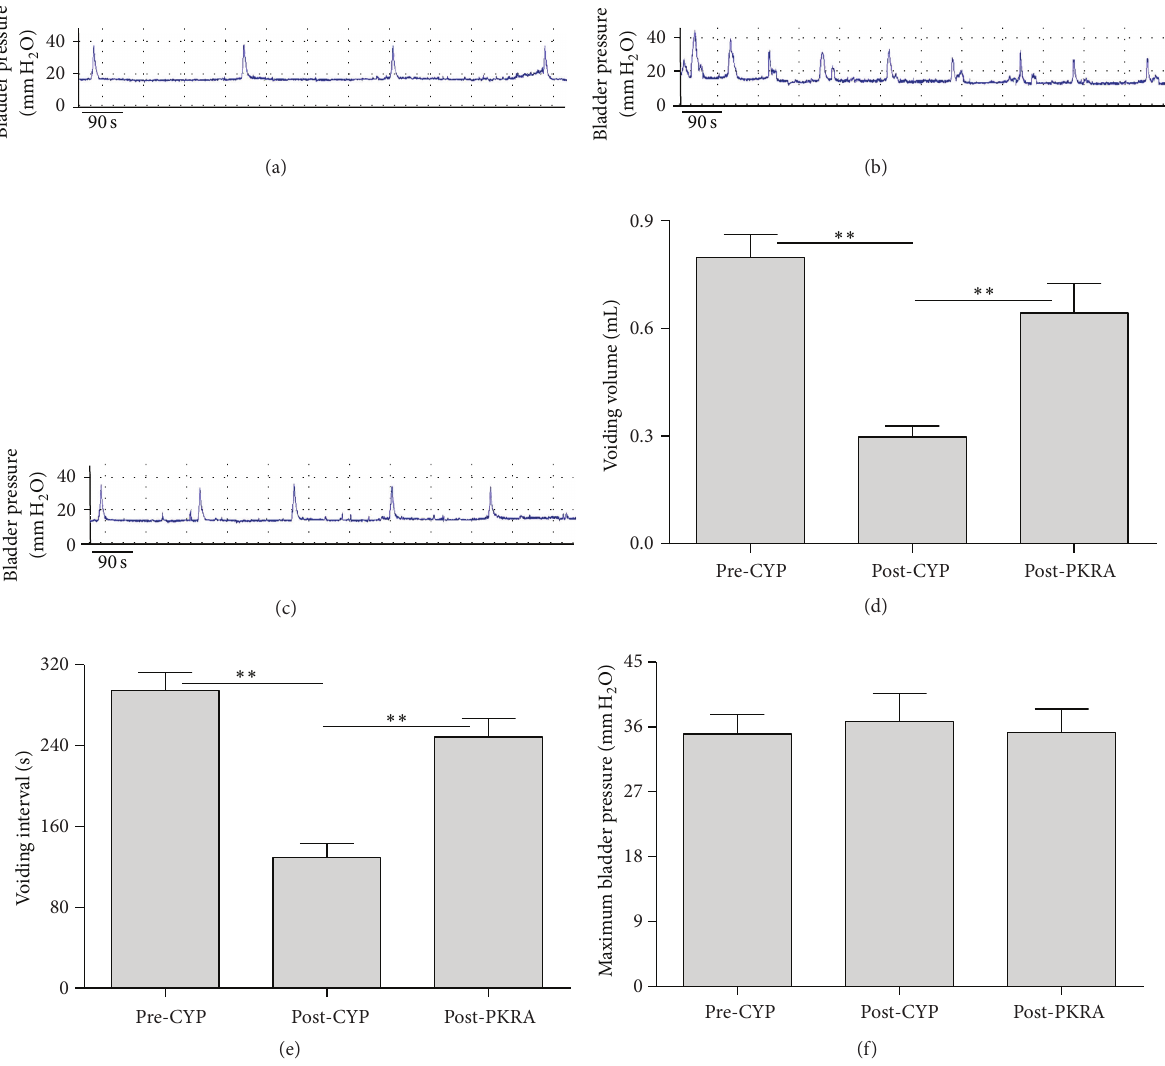
Figure 6: Effect of PKRA on bladder function in rats with 48 h CYP-induced cystitis. (a), (b), and (c) represent the pressure-volume curves for the same rat at different time points after CYP administration: (a) pre-CYP; (b) post-CYP; (c) post-PKRA. Summary showed intravesical infusion of PKRA (1 𝜇 M) significantly increased voiding volume (d) and voiding interval (e) with no effect on maximum bladder pressure (f). ∗∗ indicates 𝑃 < 0.01 . 𝑛 = 6 for each